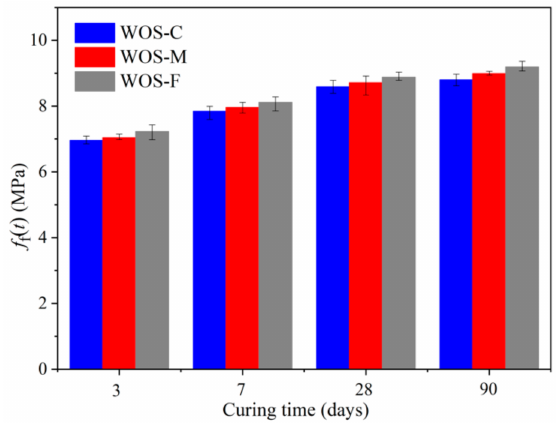
Figure 8. The effect of particle size on the f f ( t ).